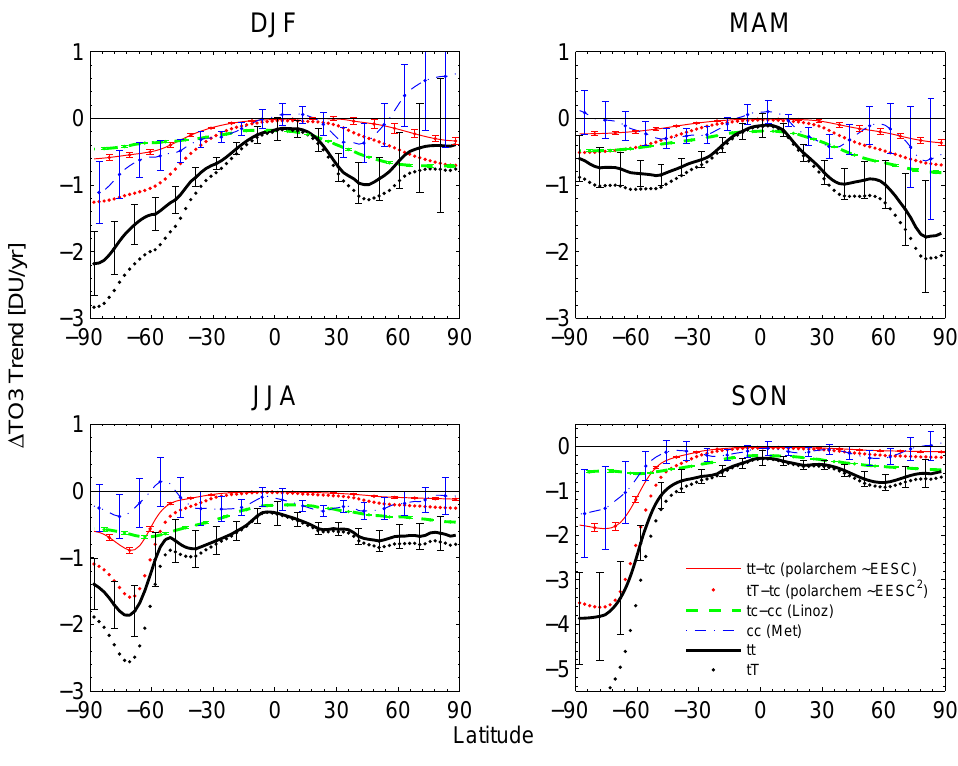
Fig. 11. Attribution of TO3 trends in the 1979–1999 period to effects of ODS change on gas phase chemistry ( tc − cc ), ODS change on polar chemistry ( tt − tc for polar chemistry ∝ EESC, and tT − tc for polar chemistry ∝ EESC), and natural variability under constant atmospheric composition ( cc ). Total trends are shown as a reference ( tt and tT